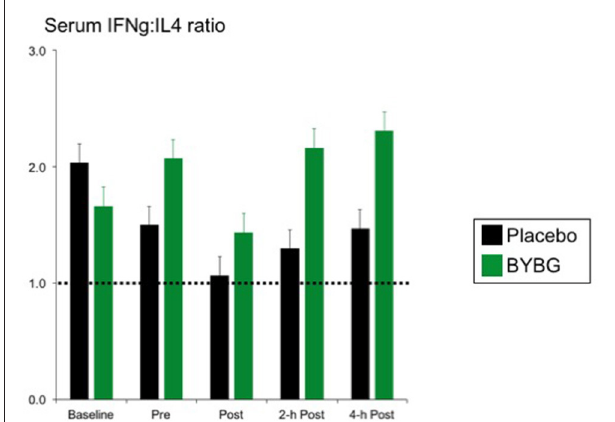
FIGURE 8 | BYBG supplementation shifts the ratio of IFN- γ /IL-4 in serum after exercise toward IFN- γ . The ratio of the serum concentrations of IFN- γ and IL-4 was calculated on an individual donor basis and the average of all donors was computed and is reported as the mean response ±